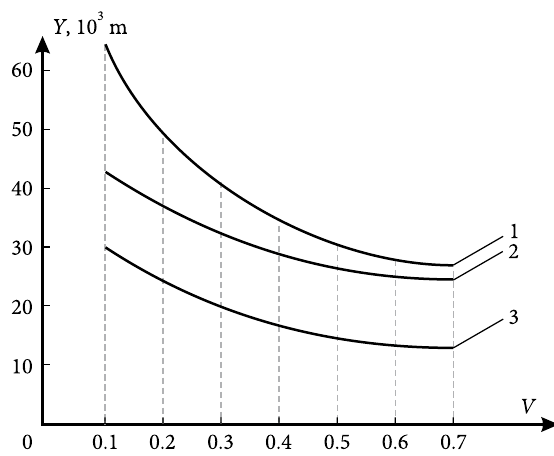
Fig. 6. Dependence of specific strengths of the cables Y vs the volume fraction of steel V : 1 – variant of hybrid composite cable on the basis of steel, GFRP and CFRP; 2 – variant of hybrid composite cable on the basis of steel, Vectran and CFRP; 3 – variant of hybrid composite cable on the base of steel, GFRP and Vectran